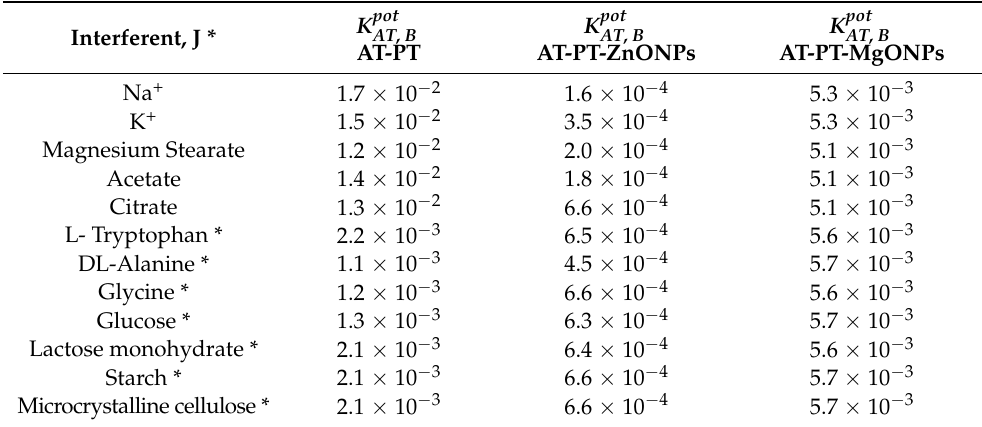
Table 2. The selectivity coefficients of the proposed AT-PT, AT-PT-ZnONP, and AT-PT-MgONP coated wire